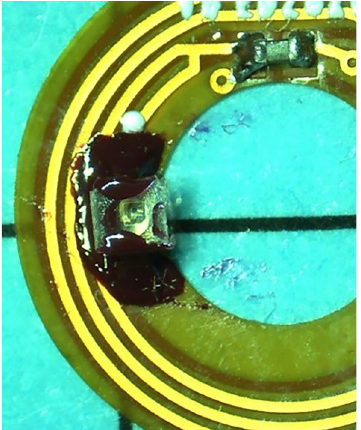
Figure 9. Circuit with a DOE mounted on the left VCSEL.